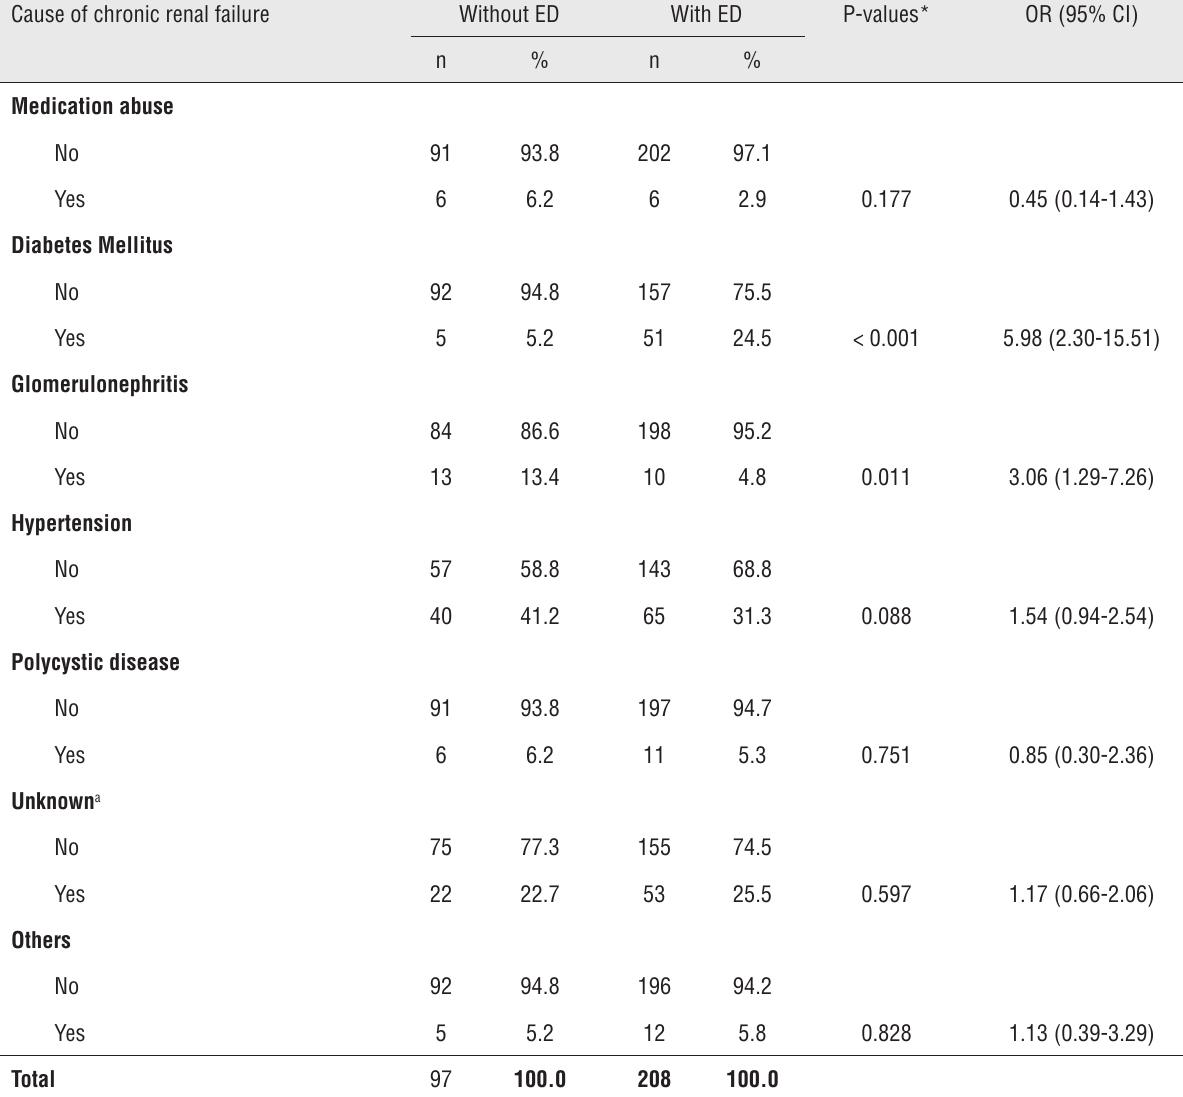
*Estimated by univariate logistic regression analysis; a Patients with more than one possible cause of chronic renal failure; ED = Erectile Dysfunction; OR = Odds ratio; P = Statistical significance; CI = confidence